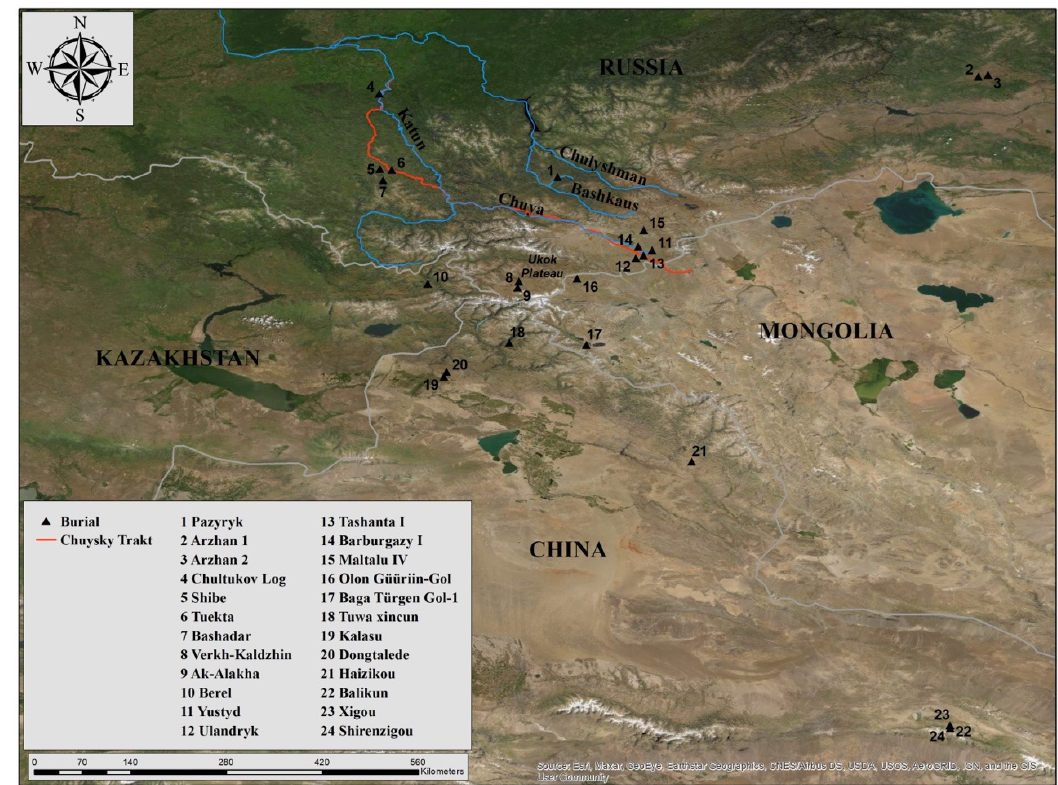
Figure 1. Map of Pazyryk Culture Sites. Map by Evan Matthew Mann.